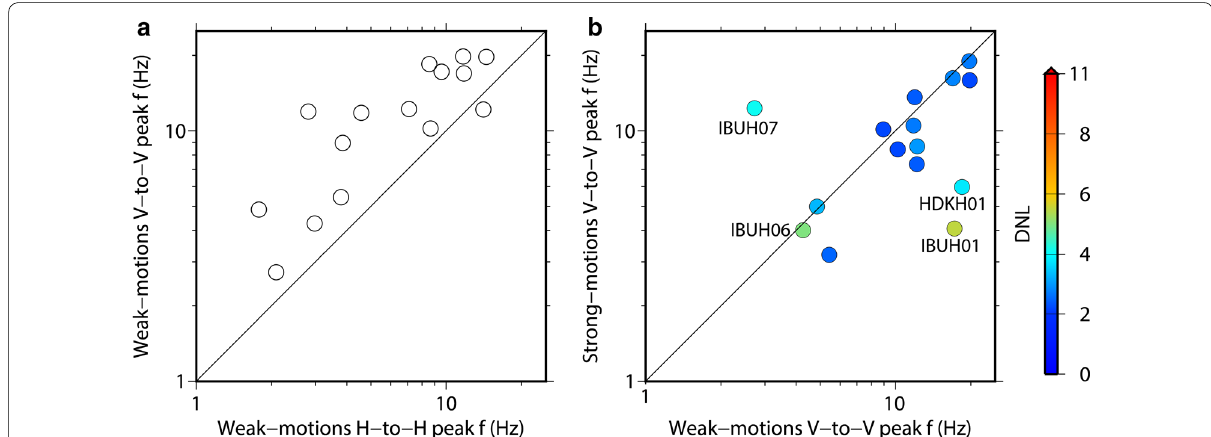
Fig. 8 a Comparison of peak frequencies between surface-to-borehole spectral ratios for horizontal components (H-to-H) ( x axis) and vertical components (V-to-V) ( y axis) during weak-motions. b Comparison of peak frequencies between surface-to-borehole spectral ratios for vertical components (V-to-V) during weak-motions ( x axis) and strong-motions ( y axis). The data points are color-coded by DNL values computed based on vertical component spectral ratios (V-to-V). Some data points that deviate largely from the diagonal line in b are provided with their site codes close to the data